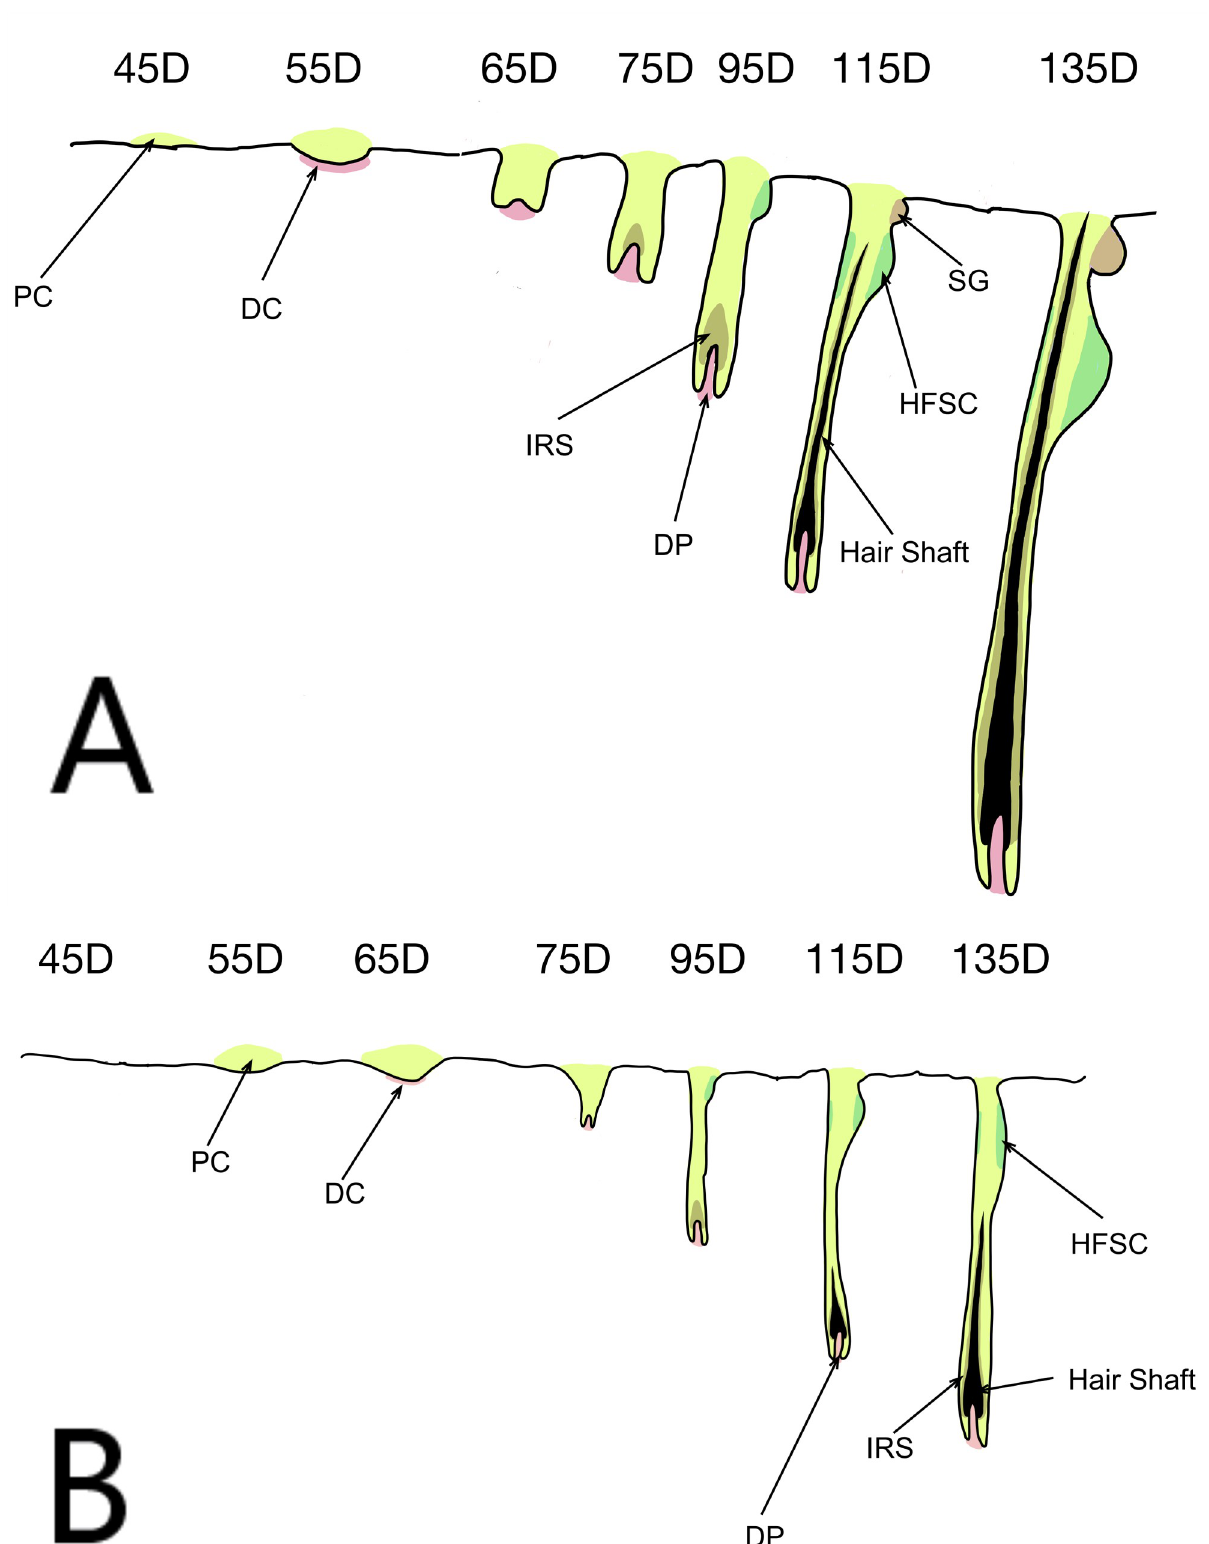
Fig 1. Schematic diagram of skin hair follicle development. (A) Primary hair follicles; (B) secondary hair follicles. PC: Placode; DC: Dermal condensate; DP: Dermal papilla; IRS: Inner root sheath; HFSC: Hair follicle stem cells; SG: Sebaceous gland. https://doi.org/10.1371/journal.pone.0243507.g001 PLOS ONE | https://doi.org/10.1371/journal.pone.0243507 December22,